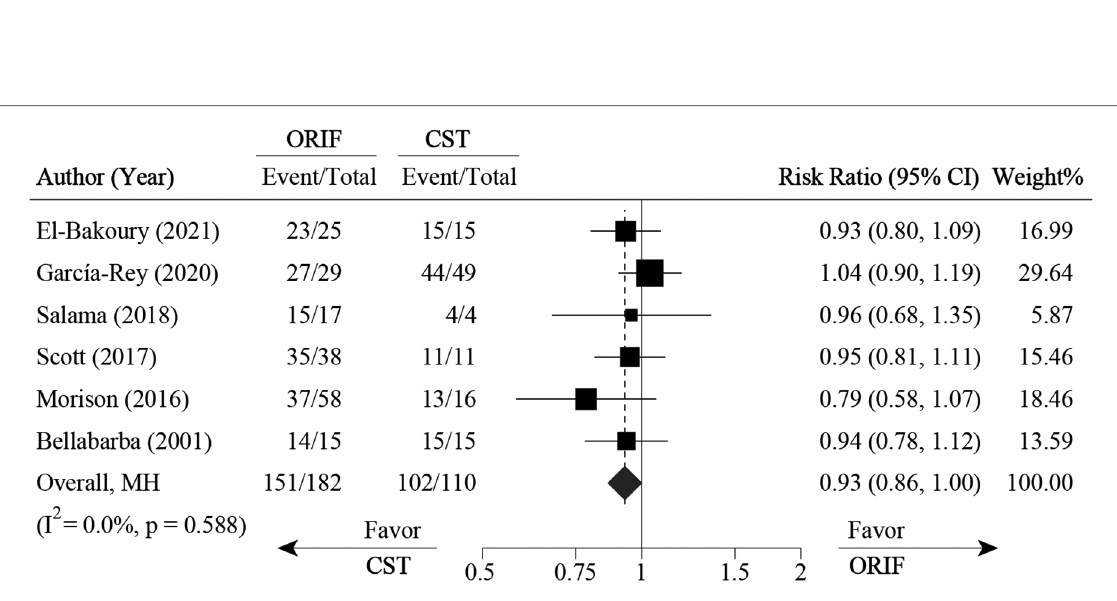
FIGURE 7 Pooled result for survival rate comparison between ORIF and conservative treatment. CST, conservative treatment or non-surgical treatment; ORIF, open reduction and internal fi xation.